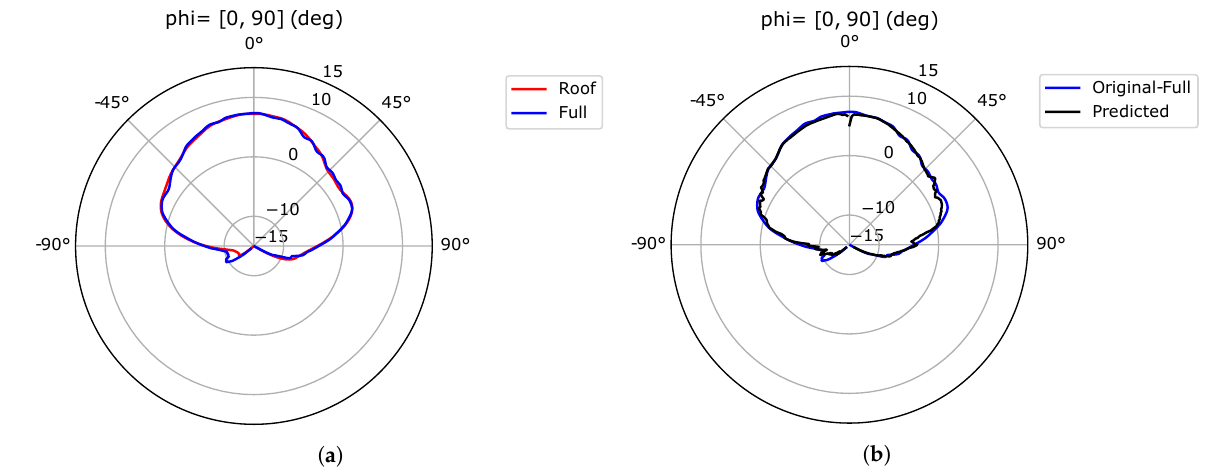
Figure 5. Realized gain. ( a ) Roof × full vehicle model simulated by CST. ( b ) Comparison of full car, simulated (CST) and predicted (U-Net).